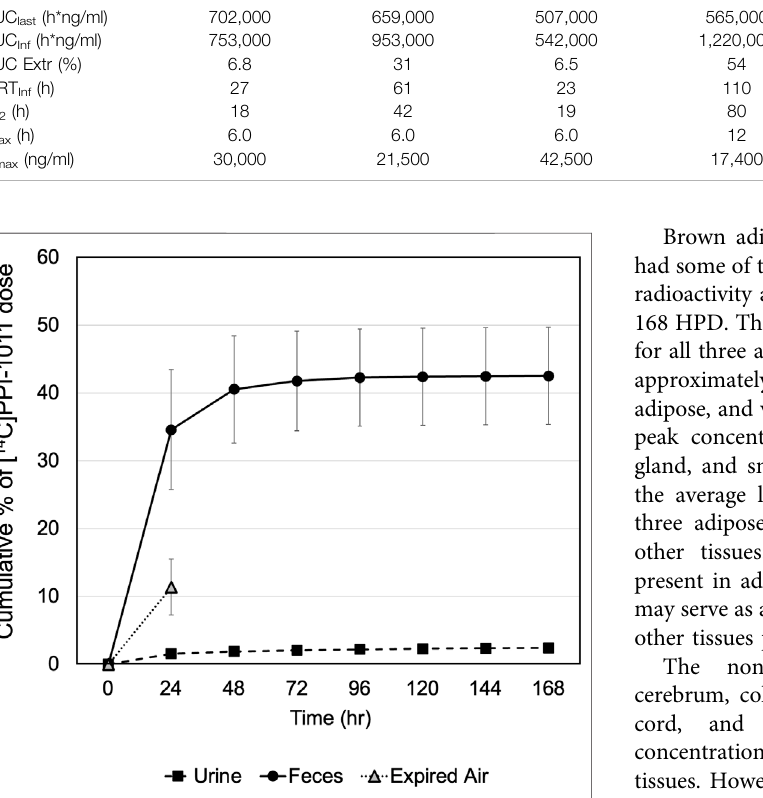
FIGURE 2 | Recovery of radioactivity in excreta of male rats following a single oral dose of [ 14 C]PPI-1011 at 100 mg/kg.